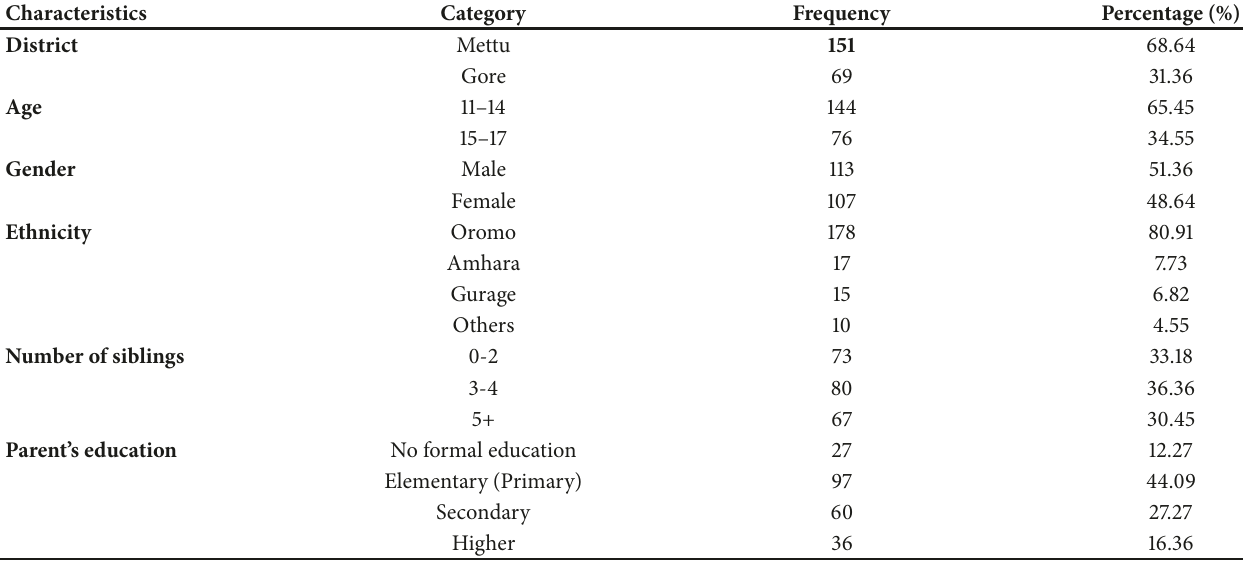
Table 1: Distributions of respondents by sociodemographic characteristics in Ilu Abba Bor Zone,